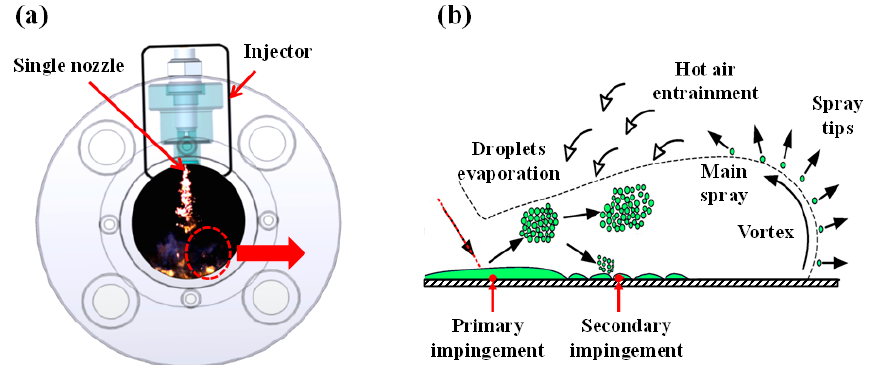
Figure 1. Schematic depicting ( a ) spray impingement; and ( b ) fuel film formation in the combustion chamber.